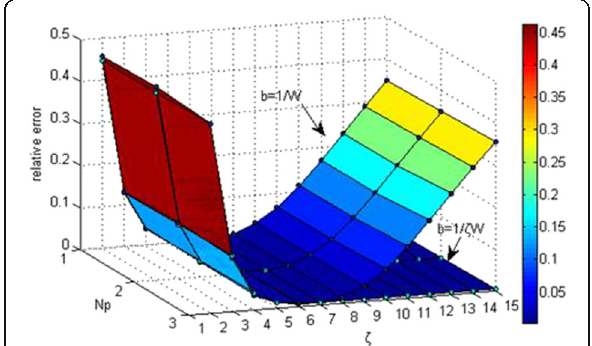
Fig. 3 Relative reconstruction error variation curve with the increasing of window stretching factor ζ and pulse number